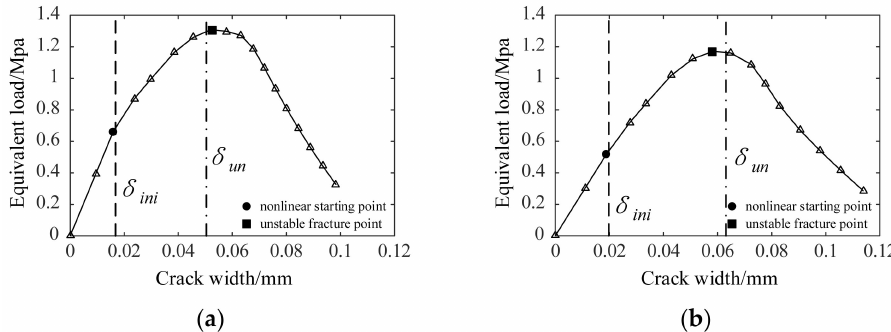
Figure 11. The curve of the equivalent load–crack width: ( a ) arch crown, ( b ) arch waist.